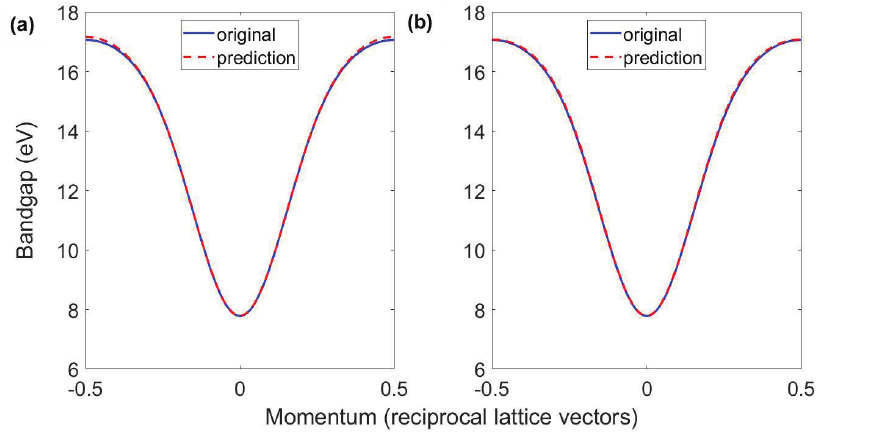
Figure 5. ( a ) Comparison of the predicted band gap from training once (red dashed line) with the desired (blue solid line) MgO band gap. ( b ) Result for prelearning method with 4500 input samples (red dashed line) and the desired MgO band gap (blue solid